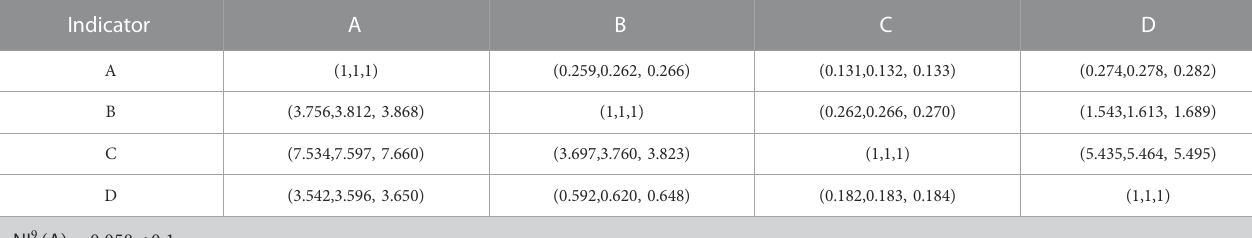
TABLE 4 Pairwise comparison matrix of criterion layer (MCS-AHP).